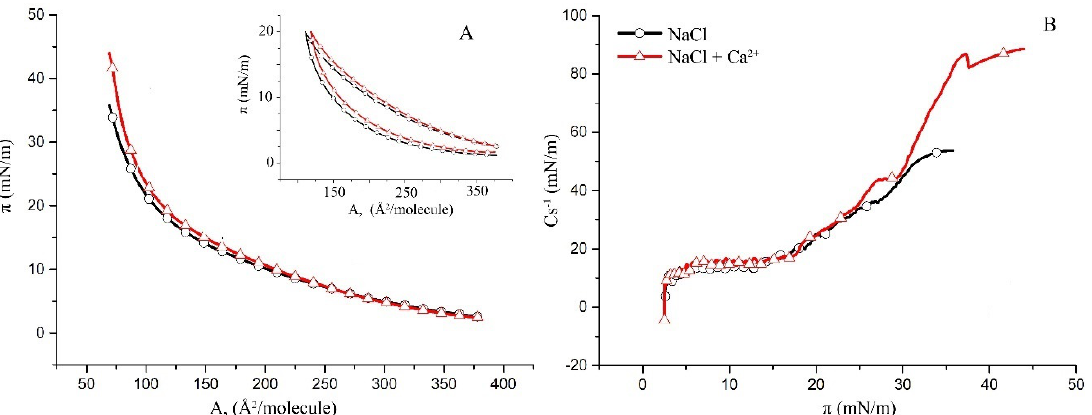
Figure 3. ( A ) Surface pressure/mean molecular area isotherms of the binary hBest1/Chol (1:58.5) monolayers in a subphase of 150 mM NaCl (black) and in 150 mM NaCl supplemented with 0.5 µM CaCl 2 (red) at 35 ± 2 °C (inset: π /A hysteresis cycles of compression–decompression); ( B ) surface compressibility moduli C s − 1 derived from the isotherms in ( A ) as a function of surface pressure.